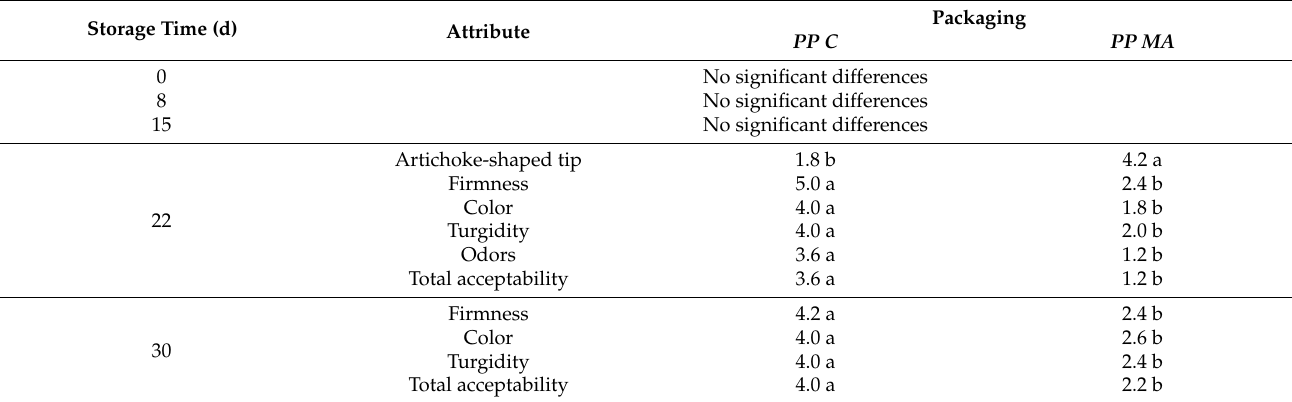
Table 4. Mean scores of the significant sensory attributes of asparagus in different packaging materials—PP C (micro- perforated coextruded PP film) and PP MA (macro-perforated PP film) during 30 days of storage. Storage Time